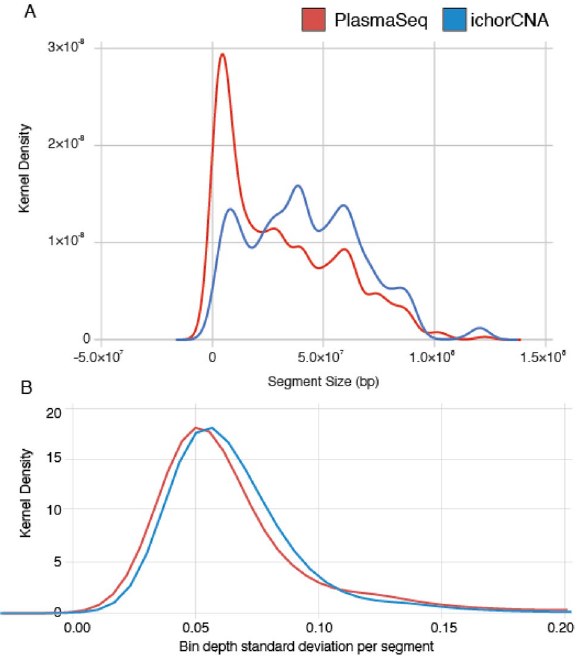
Figure 2. PlasmaSeq infers a larger proportion of shorter segments compared to ichorCNA, although the depth variation of bins within segments is approximately the same between PlasmaSeq and ichorCNA. ( A ) Distribution of segment size in base pairs across all samples using each approach. ( B ) The distribution of standard deviations of log 2 depth across all bins assigned to the same